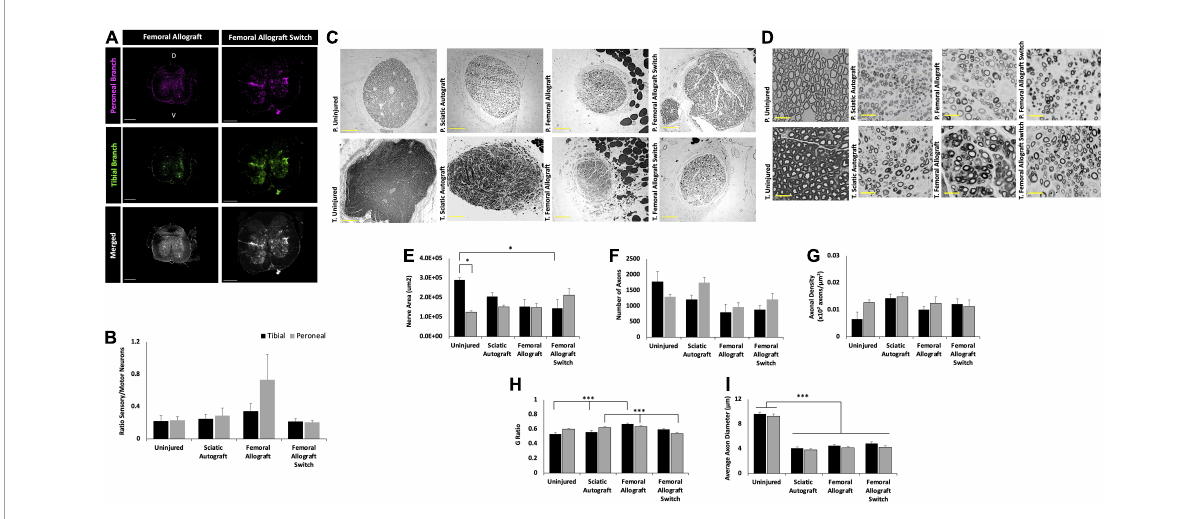
FIGURE8 Inbred Lewis to Lewis femoral allograft and femoral allograft switch group retrograde labeling and nerve morphometry. Sciatic autograft is included for reference. (A) Retrograde labeled spinal cords showing peroneal (magenta) and tibial (green) branch labeling. Scale bars 500 µ m. (B) Ratio of sensory/motor neurons counted from the peroneal (magenta) and tibial (green) nerves. (C) Cross section images of the peroneal and tibial nerves taken at 10 × . Scale bars are 200 µ m. (D) 40 × images of the toluidine blue stained sections from within the grafts; labeling of images is based on connection of the branch in the graft to the hosts peroneal or tibial distal nerve stump. Scale bars are 20 µ m. (E) Total cross sectional nerve area taken for the tibial and peroneal branches. (F) Total number of axons. (G) Axonal density. (H) G-ratio. (I) Average inner x and y plane axon diameter. n = 5 for sciatic autograft, n = 6 for femoral allografts in both orientations, ∗ p < 0.05, ∗∗∗ p < 0.001 by two-way ANOVA with Tukey post-hoc test. Error bars are SEM.